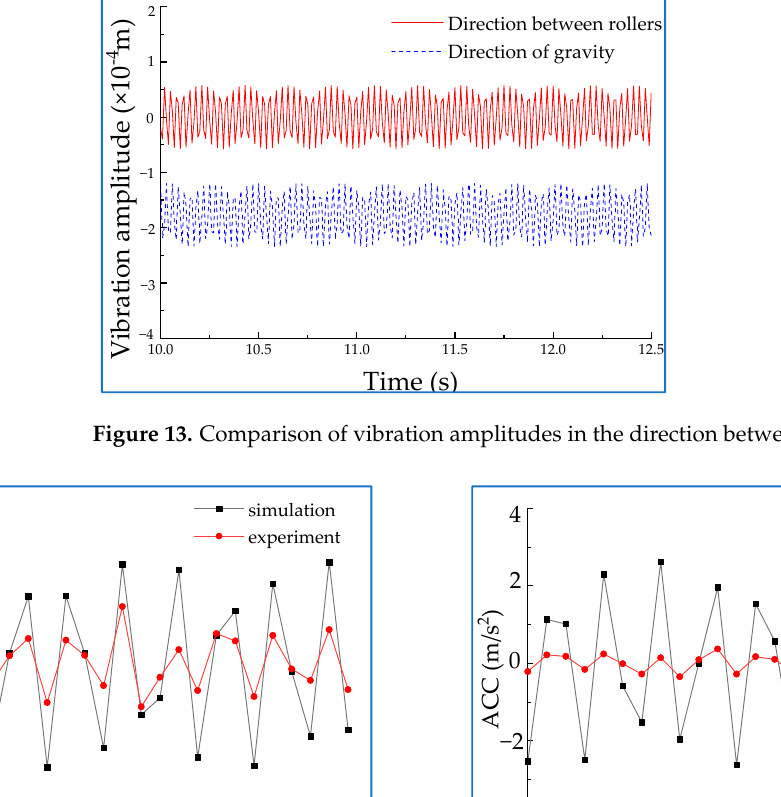
Figure 12. Vibration acceleration of rotor components at different velocities. The velocity at ( a ) 200